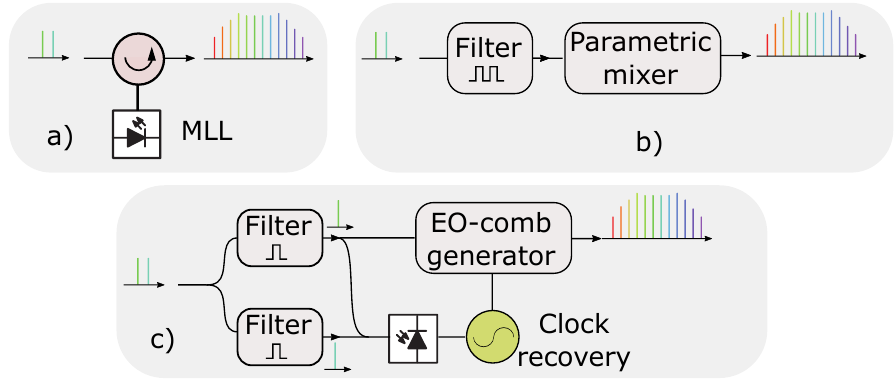
Figure 5. Schematic of different methods for regenerating a frequency comb using ( a ) a mode-locked laser (MLL), ( b ) a parametric mixer (cascaded four-wave mixing) and ( c ) an electro-optic (EO) comb with external clock